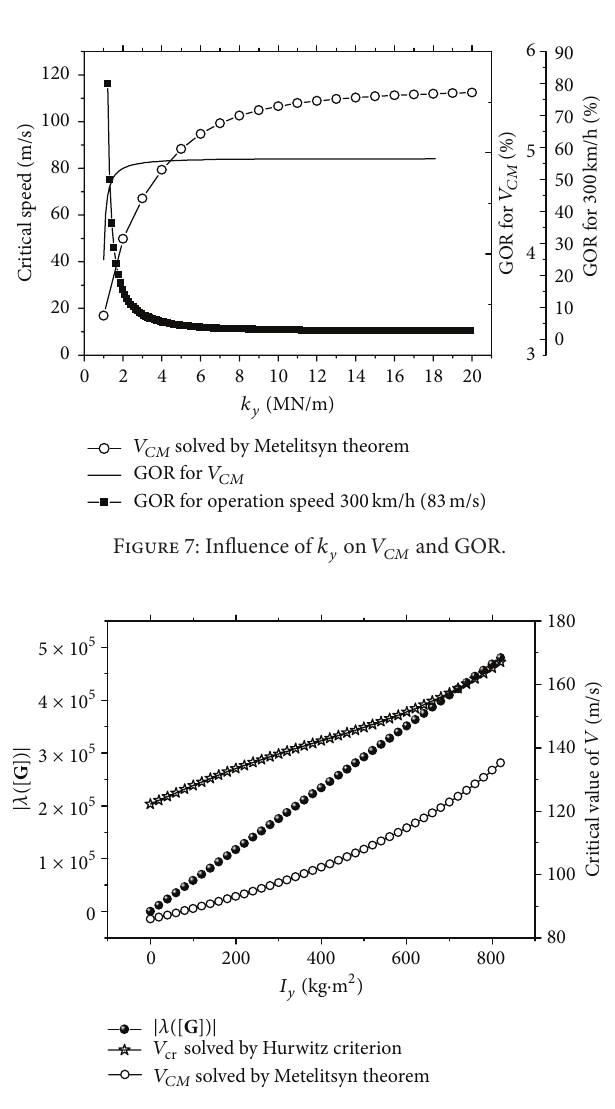
Figure 8: Influence of 𝐼 𝑦 on |𝜆([ G ])| and critical value of 𝑉 .